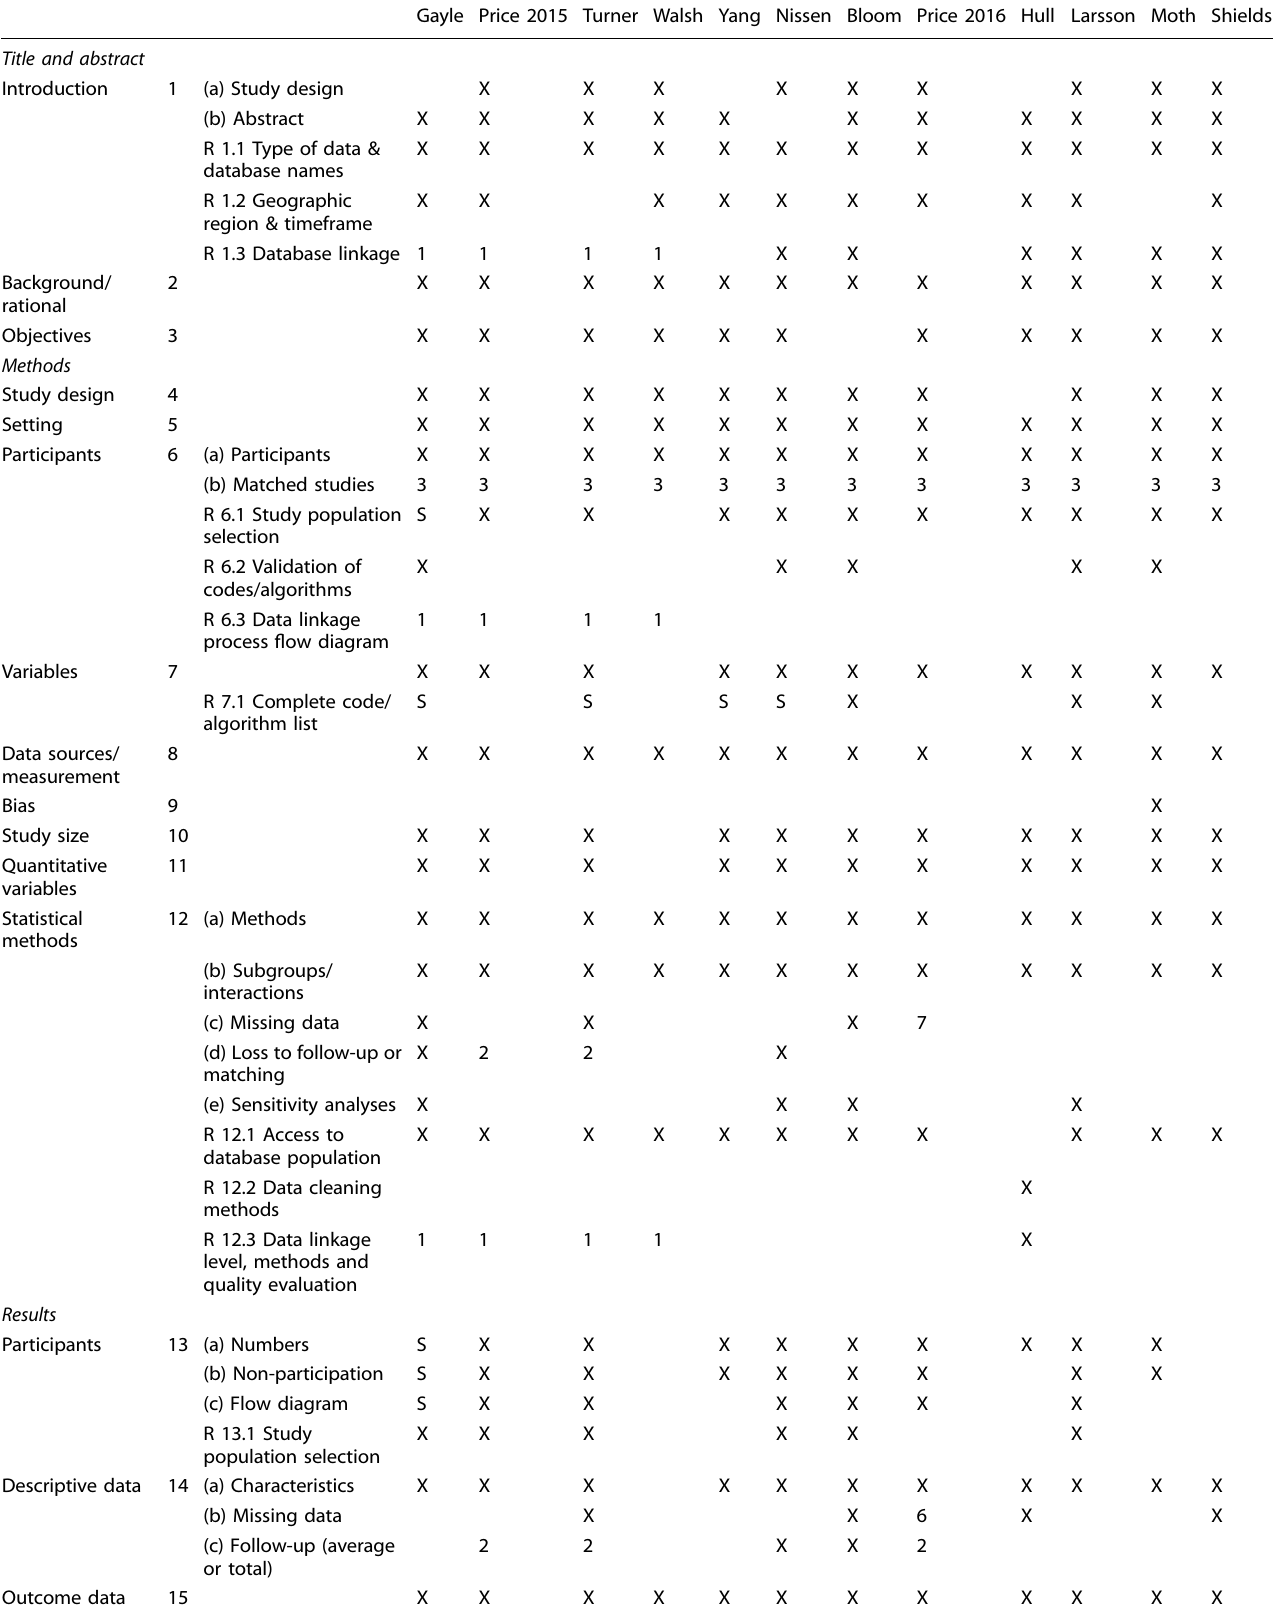
Table 5. Comparison of the quality of study reporting using the RECORD extension to the STROBE statement